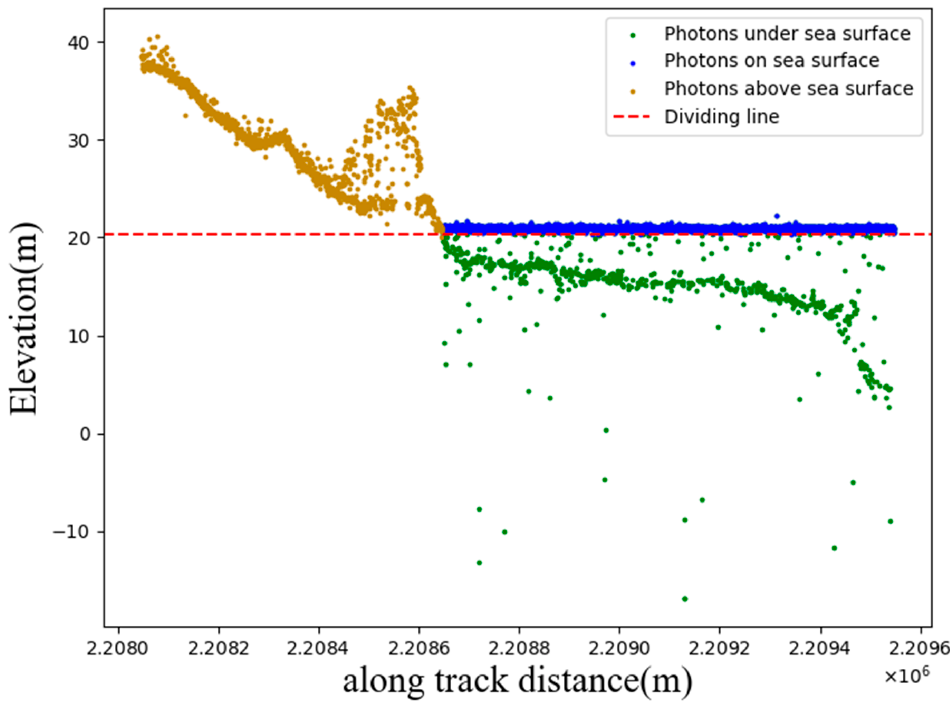
Figure 5. Photon classification diagram of 480 orbit gt1r beam.